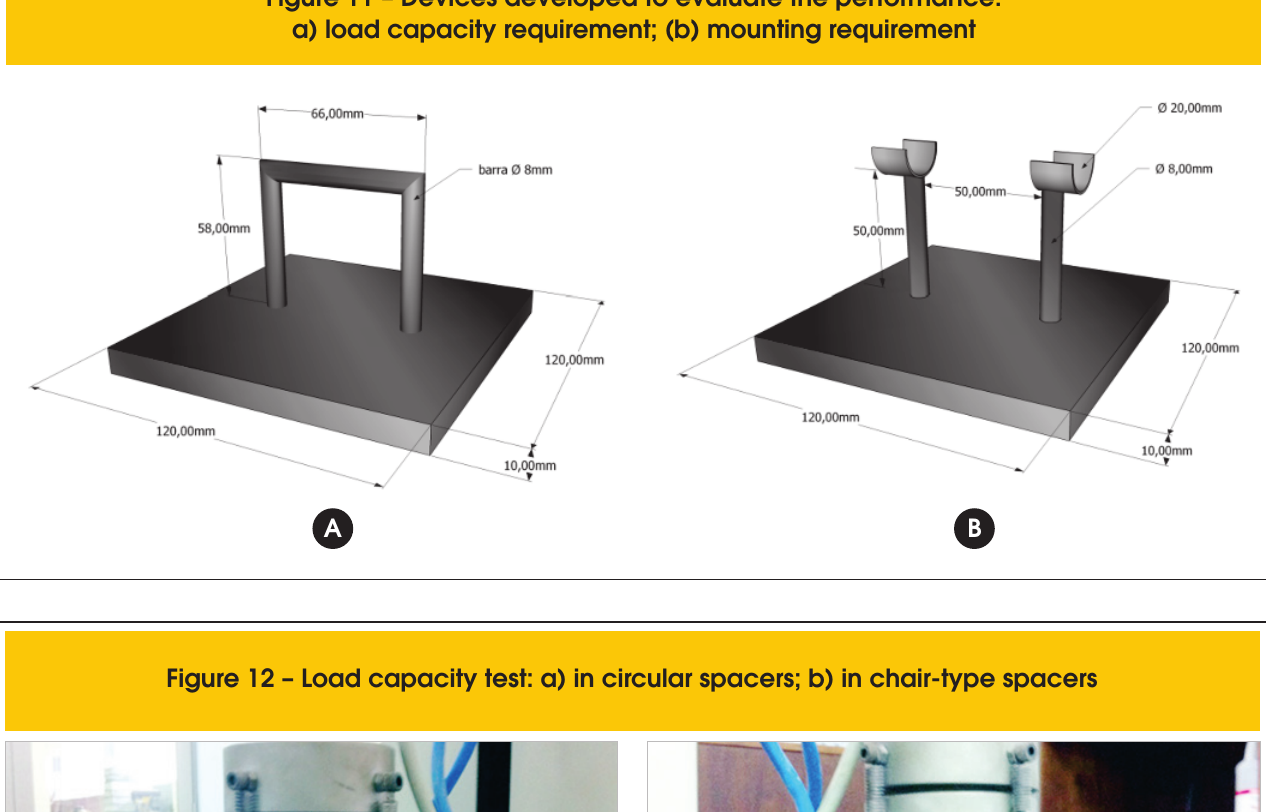
Figure 11 – Devices developed to evaluate the performance: